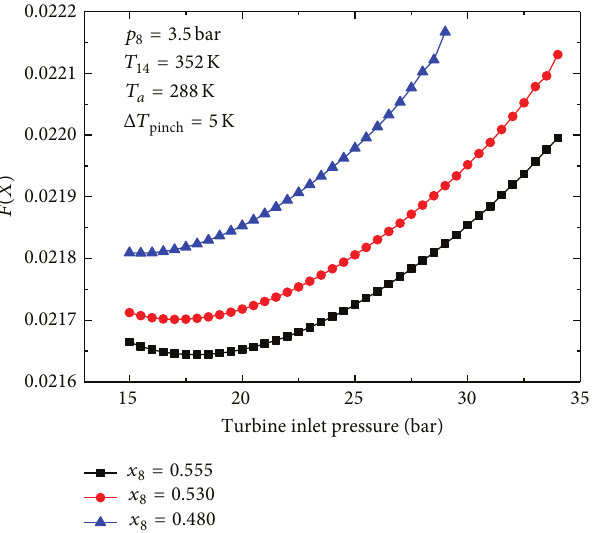
Figure 11: Variation of overall efficiency of combined cycle with turbine inlet temperature.